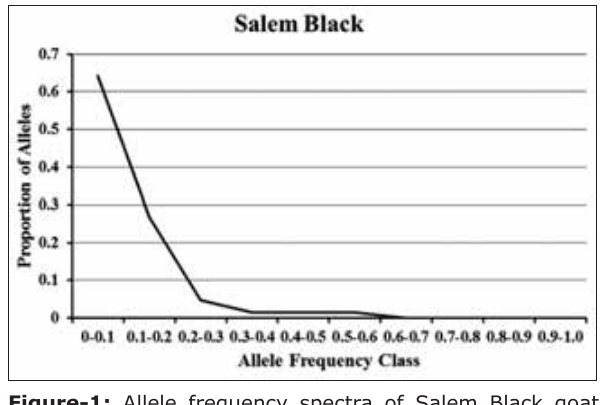
Figure-1: Allele frequency spectra of Salem Black goat showing normal L-shaped distribution and absence of recent genetic Table-3: Different tests for mutation drift equilibrium in Salem Black goats.